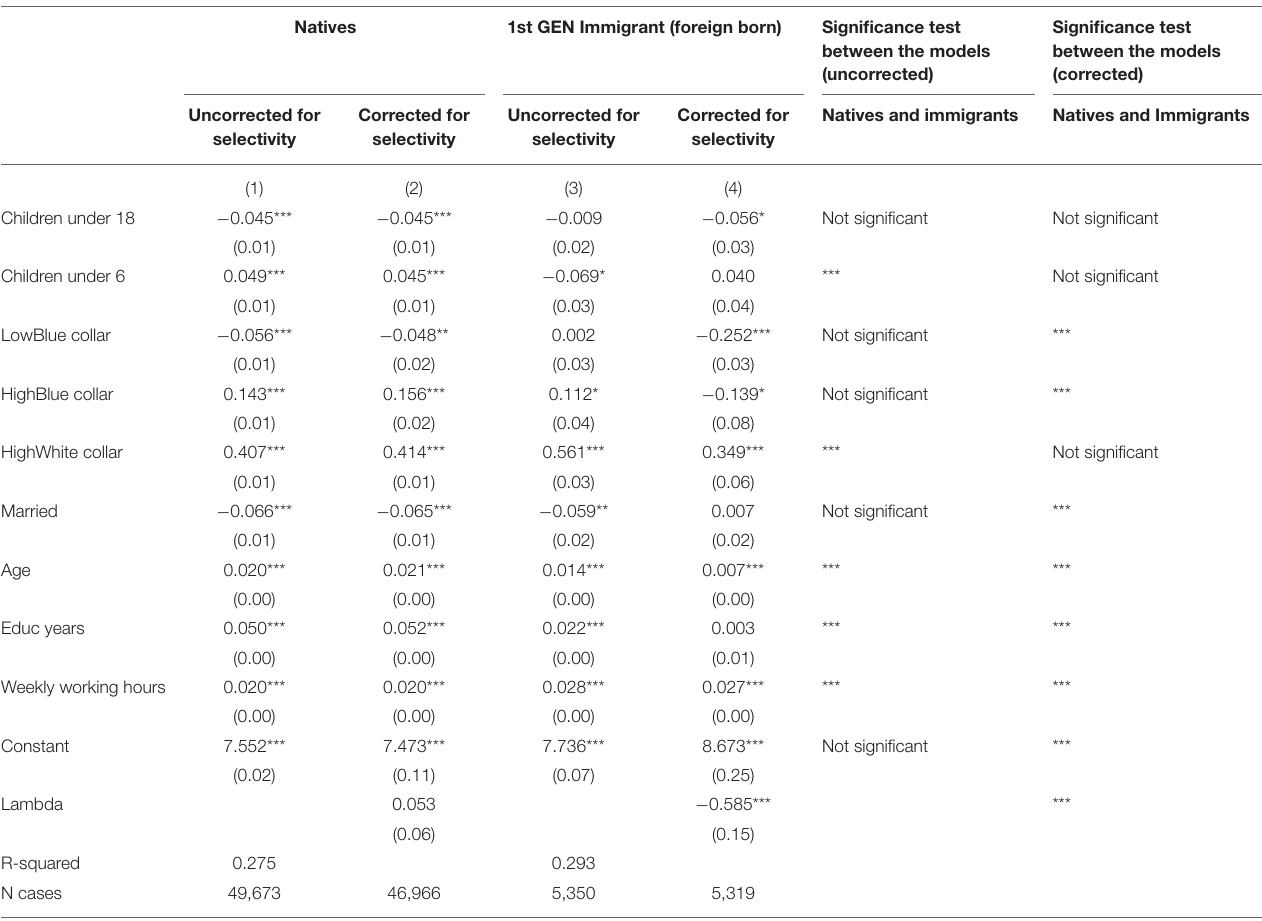
TABLE 3 | Regressions predicting the Logarithmic transformation of the yearly wages (LN income) of women in the French labor market (18–50 years old) according to their immigration status, and Heckman selection model correcting for selectivity. Natives 1st GEN Immigrant (foreign born) Significance test